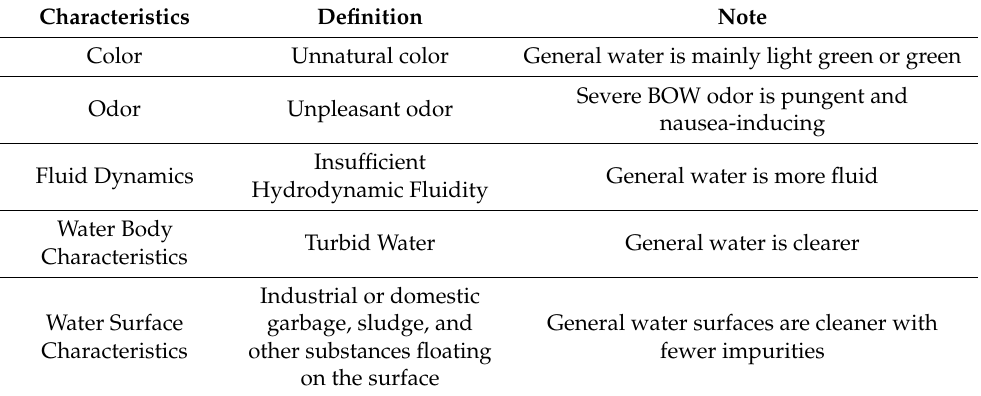
Table 2. Artificial discrimination index of BOW in the